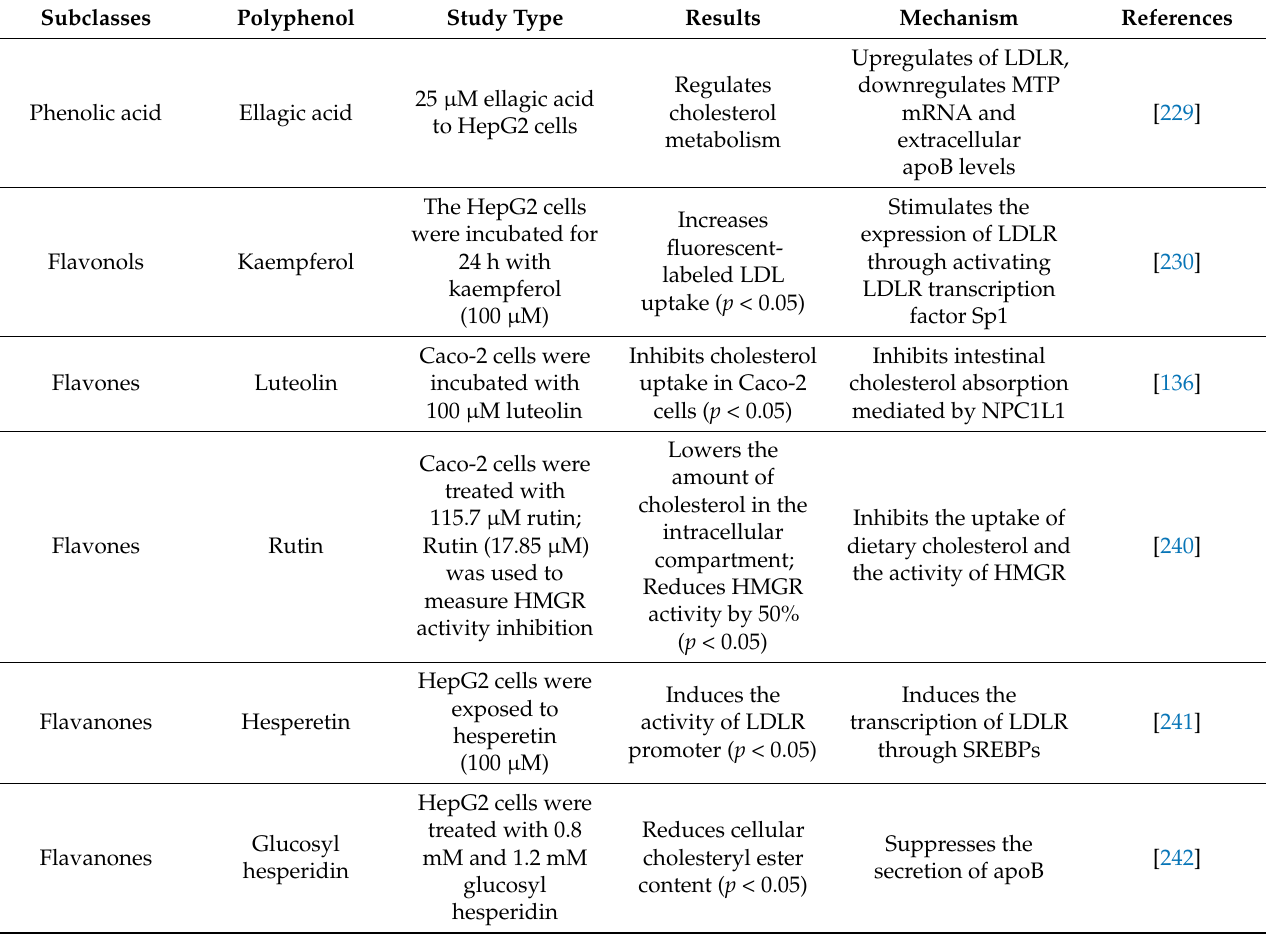
Table 5. Effect of other polyphenols on LDL-C and their mechanism based on in vitro models.